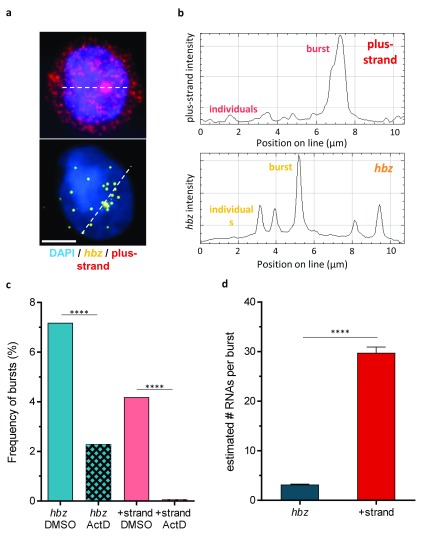
Both plus-strand and
hbz are expressed in bursts; plus-strand bursts are much larger than
hbz bursts.
a. Representative plus-strand and
hbz bursts. Dashed lines show the positions of the intensity profiles in panel b. Scale bar is 5 µm.
b. Bursts are defined as specifically stained intranuclear spots that are significantly brighter than the main population of spots.
c. Frequency of bursts is significantly reduced by blocking transcription with actinomycin D (n = 12,317 DMSO-treated cells, 7,120 actinomycin-D-treated cells from two replicates each of clones A and B).
d.
hbz bursts are small and uniform in size, whereas plus-strand bursts are significantly larger and more variable. SEM is shown, with 514 plus-strand and 800
hbz bursts from the pooled plus-strand-competent clones.